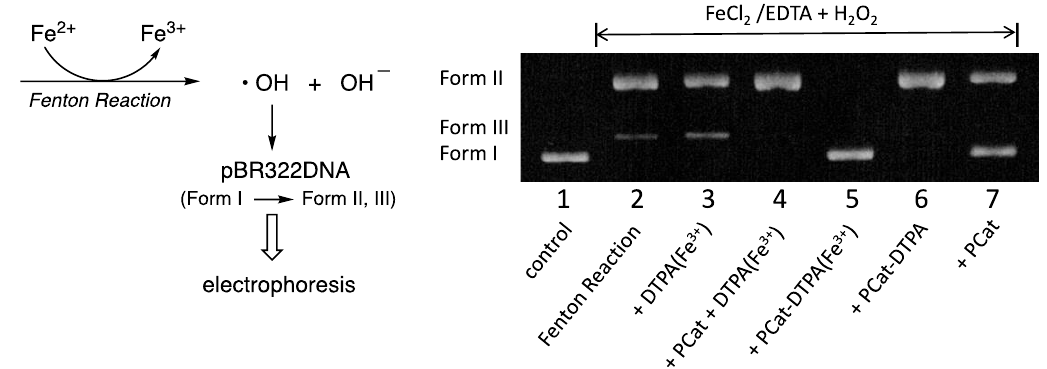
Figure 5. Effects of PCat analogs on pBR322 DNA strand breaks induced by the Fenton reaction system. DNA subjected to the Fenton reaction in the absence (lanes 1 and 2) or presence of PCat analogs (lanes 3‒7) was incubated at 37 °C for 0.5 h with 10 µM FeCl 3 , 10 µM EDTA, and 10 mM H 2 O 2 in the absence or presence of 100 µM of the test compounds.